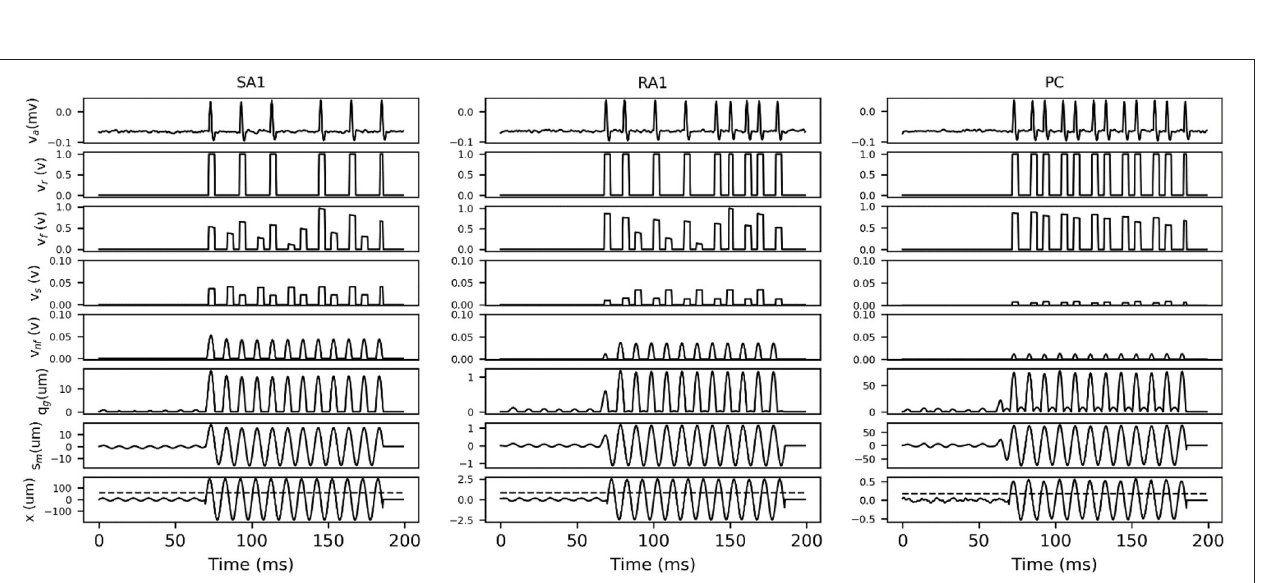
FIGURE 3 | Details of intermediate signals in response (100ms frame) to two typical sinusoidal stimuli with frequency of 100Hz and peak amplitude below (first 37ms) and above (37 to 100ms) the threshold for afferent type. The black dotted line in bottom trace indicates the threshold at 100Hz, which was calculated according to equation (2) by substituting the fitting parameters in Table 1 . x , skin mechanical indentation; s m , mechanical output of TCF; q m , mechanical output of rectifier; v nf , voltage encoding normalized firing rate; v s , voltage of sampling firing rate; v f , voltage of frequency modulation; v r , comparer output voltage; v a , Action